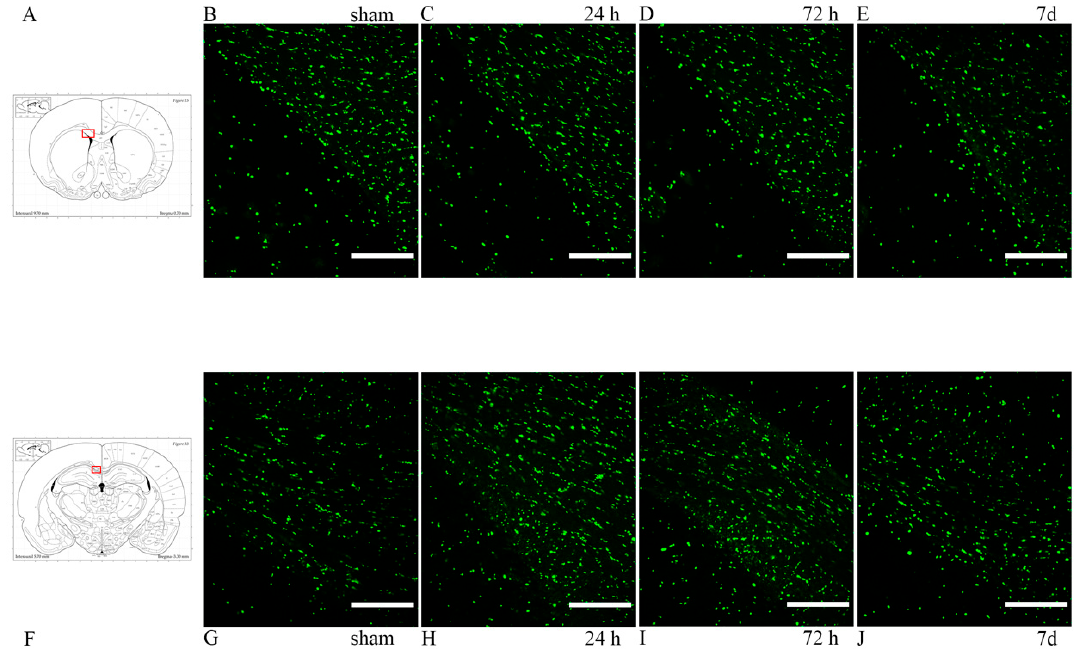
Figure 4. Olig2 expression in the corpus callosum. ( A , F ) The highlighted area refers to the area represented in the photographs on the same row. ( B – E ) Olig2 expression in the corpus callosum, at its interface with the lateral ventricle at around 1 mm from bregma. ( G – J ) Olig2 expression in the corpus callosum at around − 3 mm from bregma. Scale bar = 200 μ m.